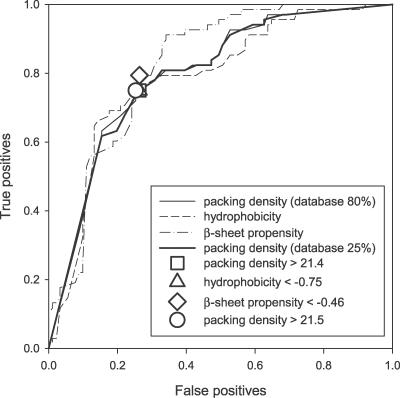
ROC Curves for Prediction of Amyloidogenic Regions in the Database of Fibril Formers and Fibril Non-Formers PeptidesThe symbols correspond to values chosen as thresholds.